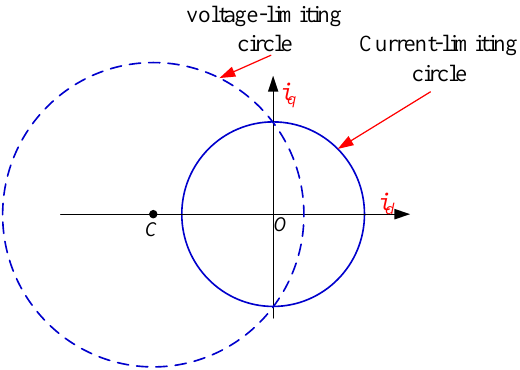
Figure 2. Operating regions of PMSM in dq component current plane.